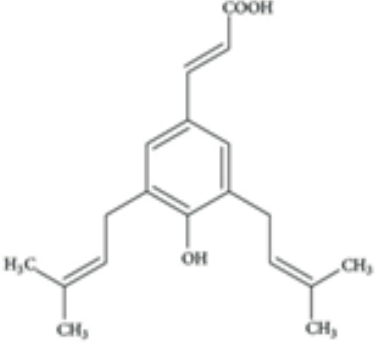
Figure 4 - Molecular structure of Artepillin